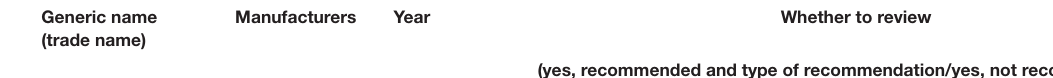
TABLE 1 | HTA assessment for orphan drugs.